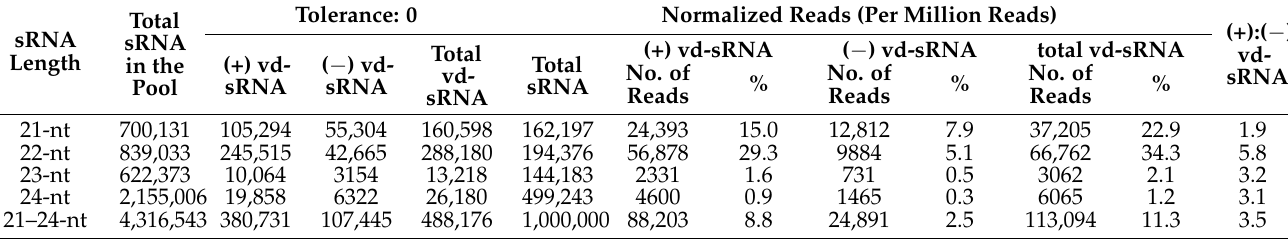
Table 2. Summary of the sRNAs identified by NGS from PSTVd-I-inoculated tomato plants cv. Rutgers at zero mismatch with the PSTVd-I